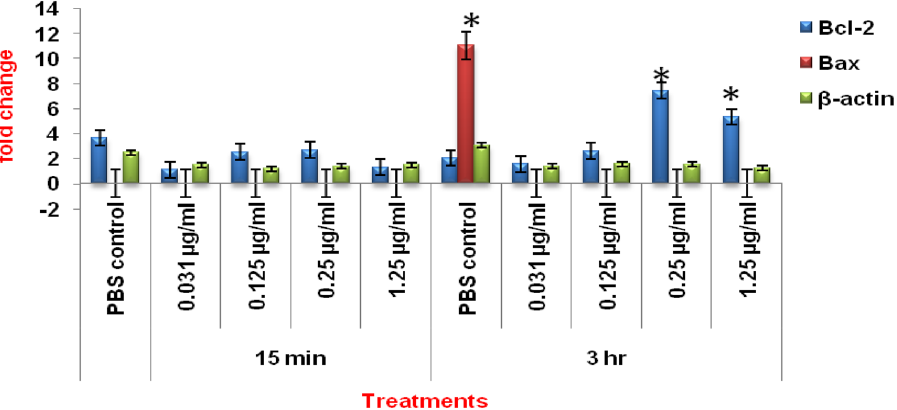
Figure 11. Relative mRNA expression of the apoptotic ( Bax ), anti-apoptotic genes ( Bcl -2) and housekeeping gene (β- actin ) in the spermatozoa following treatment of semen samples with different concentrations of mercuric chloride at different time intervals. Vertical bars represent the mean ± SE. Asterisk ( * ) on bars represent the significant differences between the PBS control and different treatment groups at different time